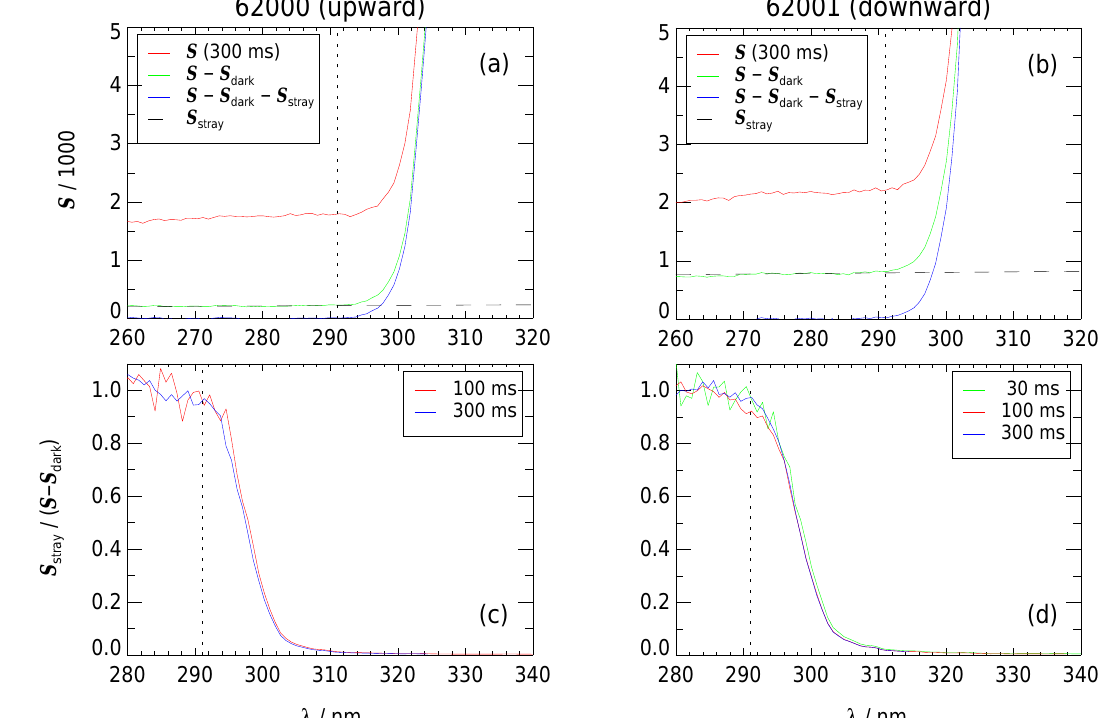
Figure 13. Examples of flight raw data and evaluations of instruments 62000 (lower hemisphere, left) and 62001 (upper hemisphere, right). Data were obtained during a HALO flight on 20 December 2013, 17:30UTC, over the North Atlantic (15.0 ◦ N, 55.9 ◦ W, 13.2km) under conditions with few scattered low-lying clouds (solar zenith angle 47 ◦ , ozone column 245DU). In panels (a) and (b) different colors indicate the evaluation steps: raw data (red), background subtraction (green) and stray-light subtraction (blue). Stray-light signals (dashed black lines) were determined by linear regression of background-corrected signals in a range of 270 to 291nm (cutoff wavelength). In panels (c) and (d) the contributions of the inter- and extrapolated stray-light signals are shown for the integration times eventually used in the displayed, most affected and atmospherically relevant wavelength range >